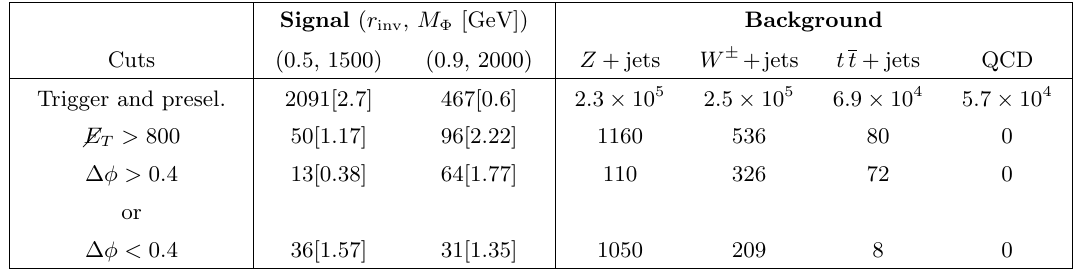
Table 3 . Cut-(cid:13)ow table for t -channel production for = 37 fb (cid:0) 1 at 13 TeV LHC. The coupling L (cid:21) = 1 is taken for the signal. The numbers in brackets correspond to an estimate of the signi(cid:12)cance s= p s + b at each stage of the cut-(cid:13)ow, where s ( b ) is the number of signal(background)